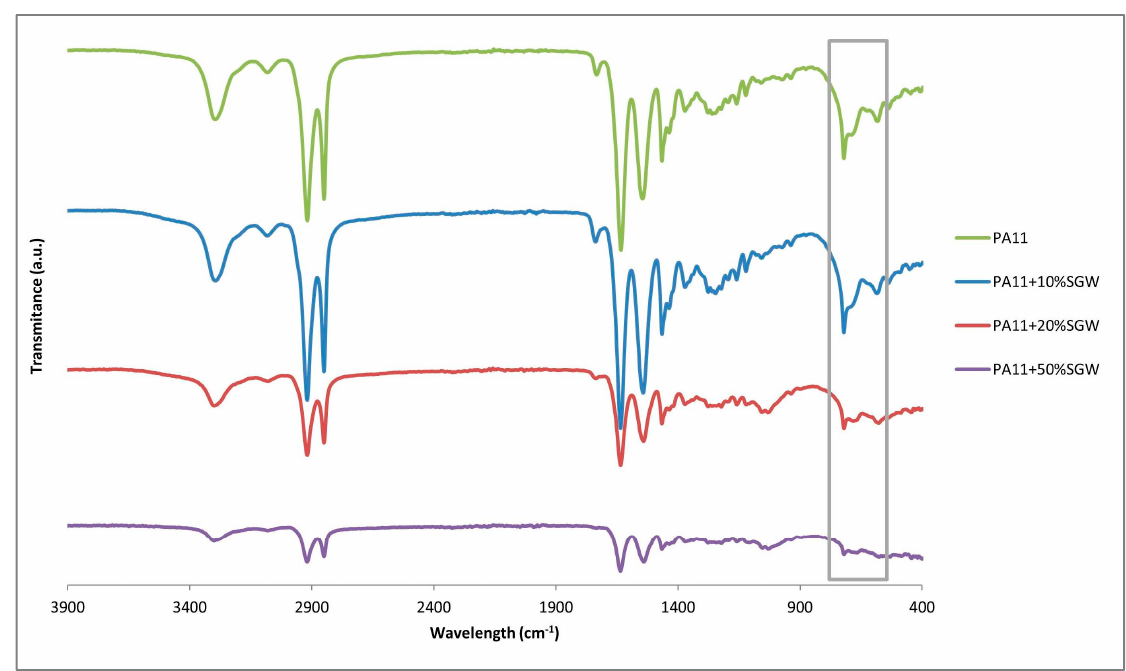
Figure 6. FT-IR PA11 and PA11-SGW composites.